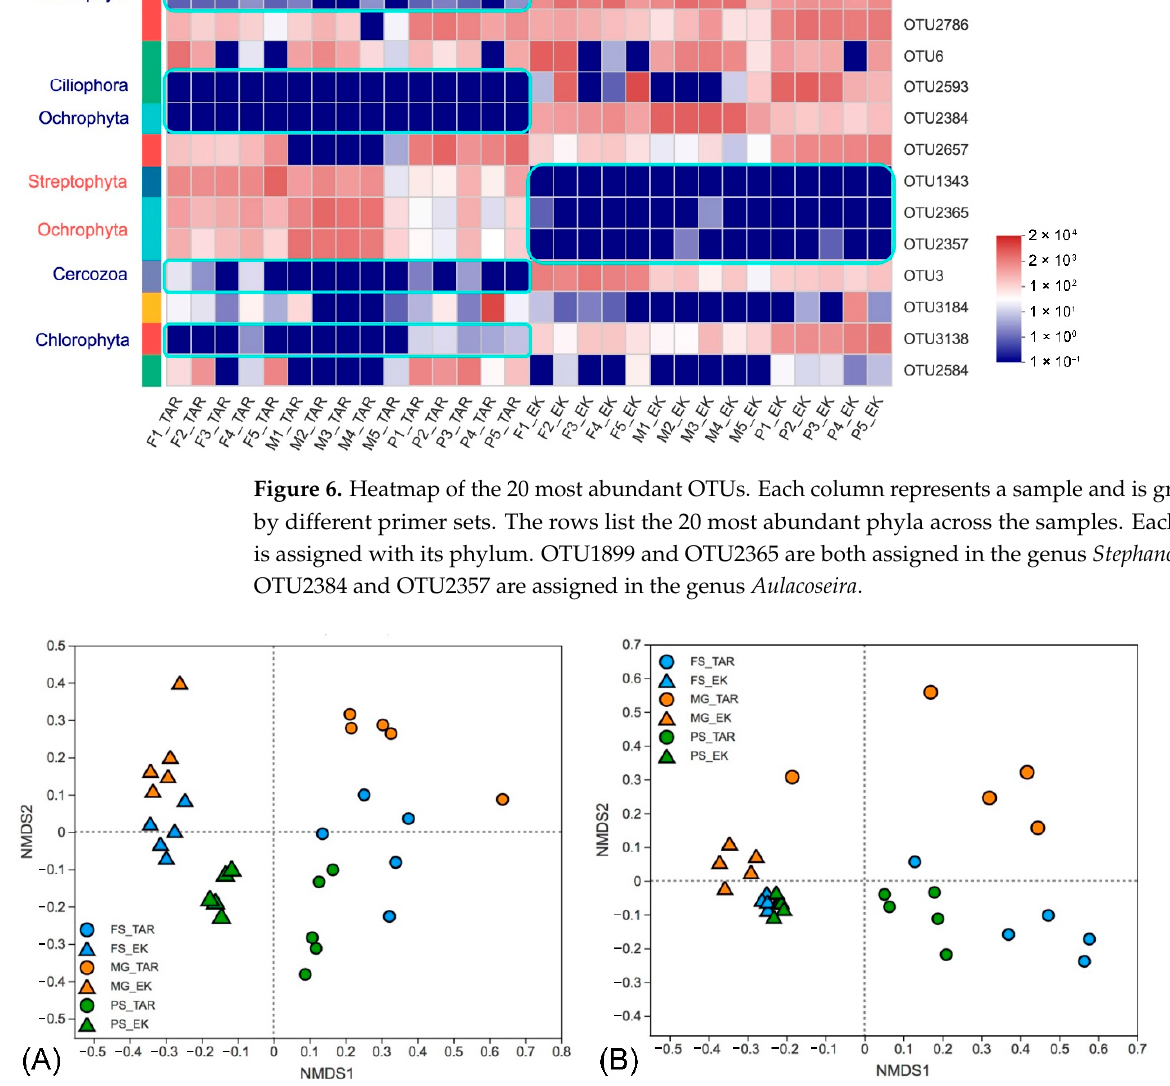
Figure 7. Nonmetric multidimensional scaling ordination of eukaryotic communities detected by two primer sets using the FS, PS and MG kits based on Bray–Curtis distances ( A ) and unweighted UniFrac phylogenetic distances ( B ).